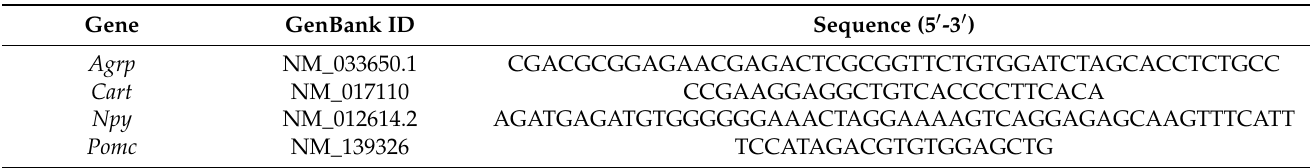
Table 1. List of in situ hybridization